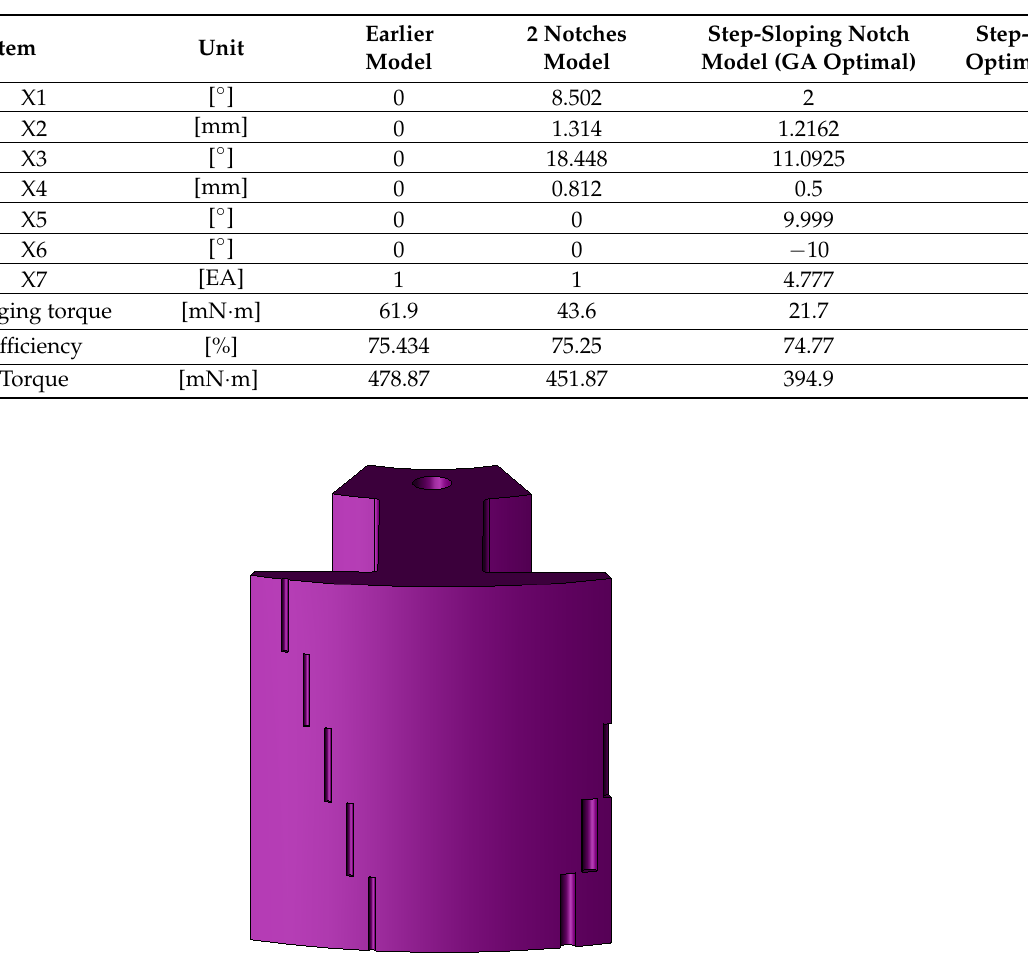
Table 4. Results of optimal design.